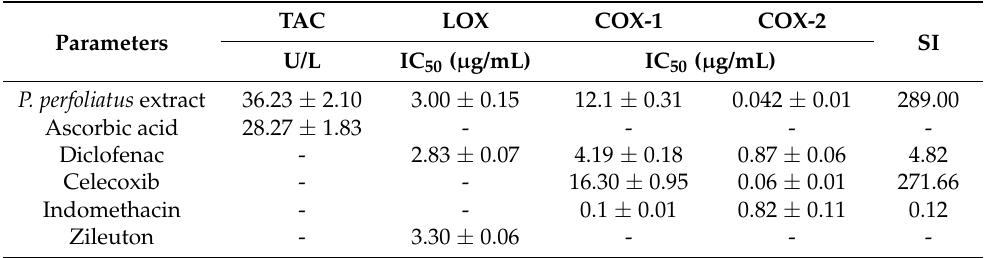
Table 2. In vitro inhibitory activities and total antioxidant capacity of P. perfoliatus